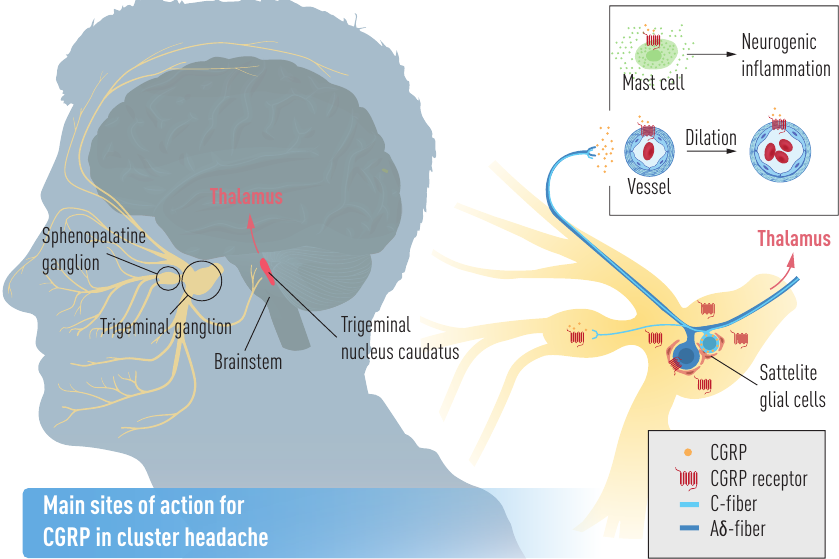
Figure 3. Main sites of action for CGRP in cluster headache. CGRP originates in the trigeminal ganglion with sensory C- and A δ -fibers that project to various parts of the face and head, as well as to intracranial